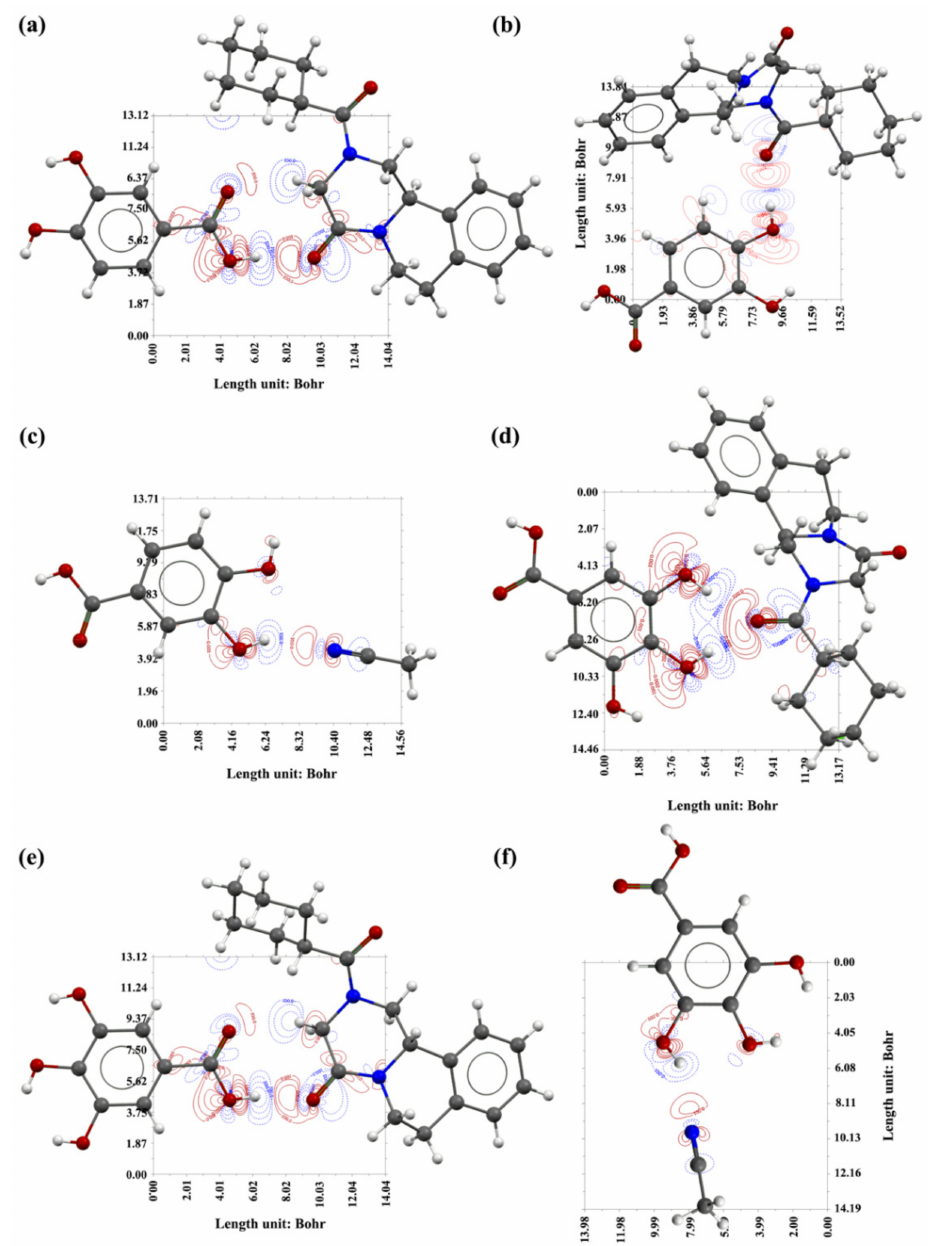
Figure 2. Hydrogen bond motifs and the corresponding contour map of the electron density difference of two cocrystal acetonitrile solvates. Hydrogen bond interaction: ( a ) PRA-PA-1; ( b ) PRA-PA-2; ( c ) PA-ACN; ( d ) PRA-GA-1; ( e ) PRA-GA-2; ( f )